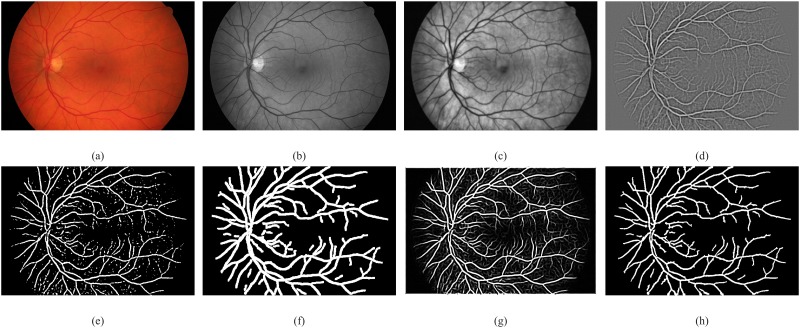
Visual presentation of the Proposed system major processing stages.(a) Input RGB photograph from HRF database (b) Green channel (c) CLAHE applied result (d) Difference image (e) Otsu threshold resultant image (f) Postprocessed dilated image (g) Frangi filter enhanced image (h) Final image using AND Operation.